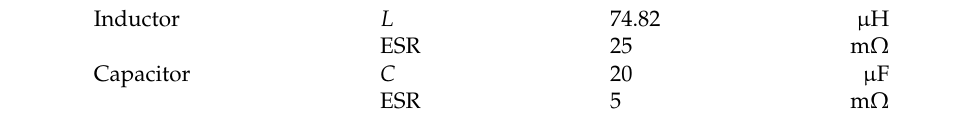
Table 2. Conventional boost converter design.